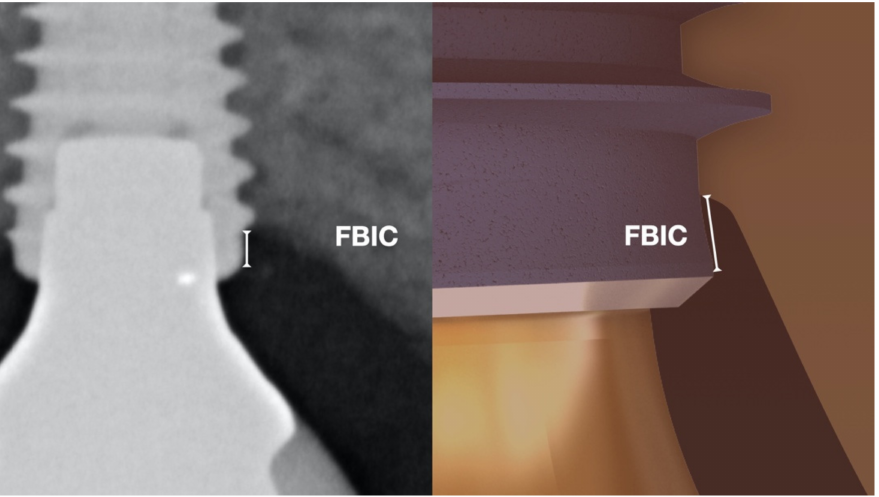
Figure 4. FBIC (first bone to implant contact) measure on a periapical radiograph ( left ) and the schematic detail ( right